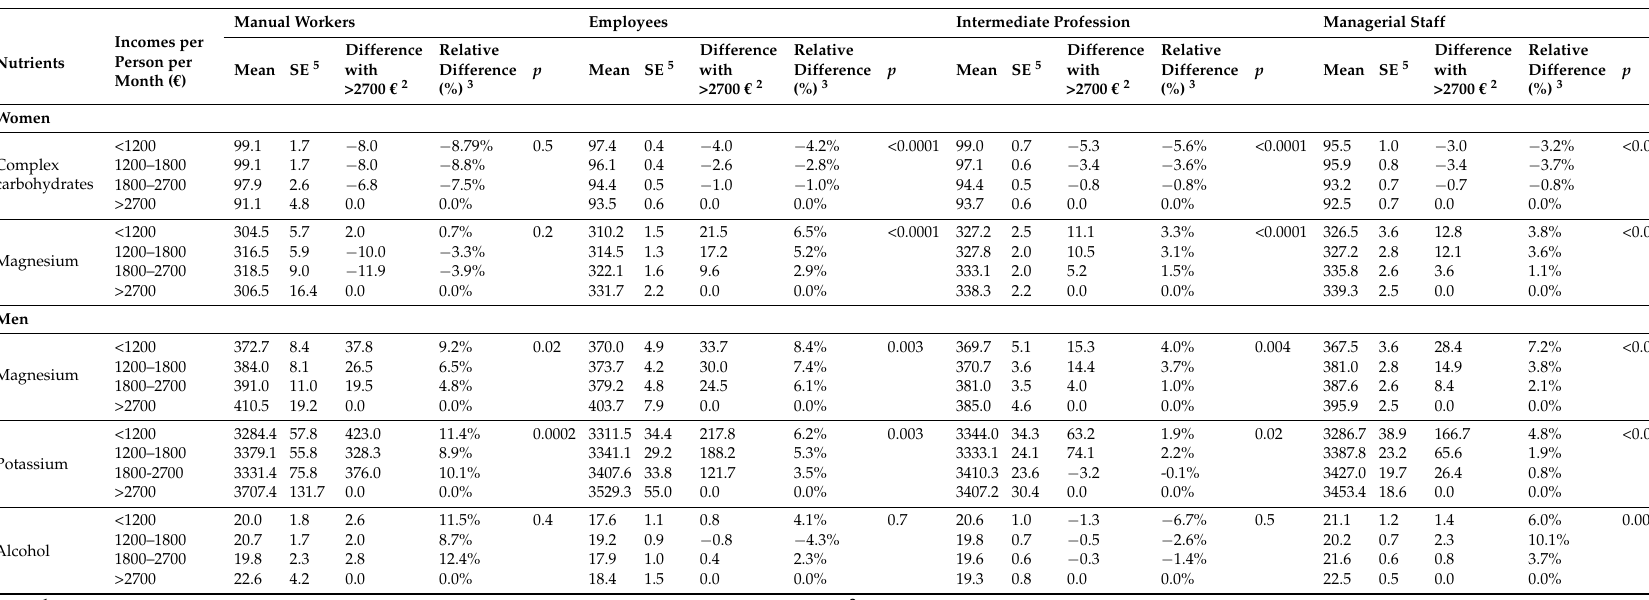
Table 6. Associations between dietary intake of complex carbohydrates, magnesium, potassium and alcohol and income stratified by occupational level in women ( N = 72,154) or men ( N = 19,746) 1,4